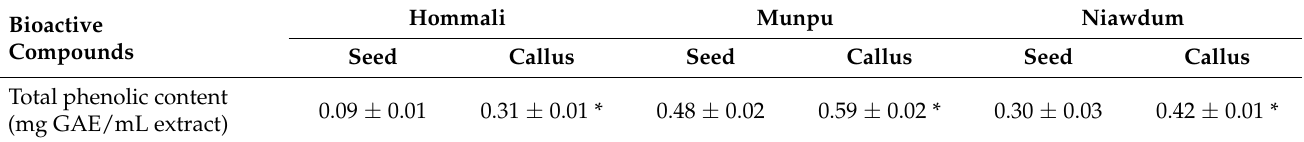
Table 3. Total phenolic contents of rice callus and seed extracts.